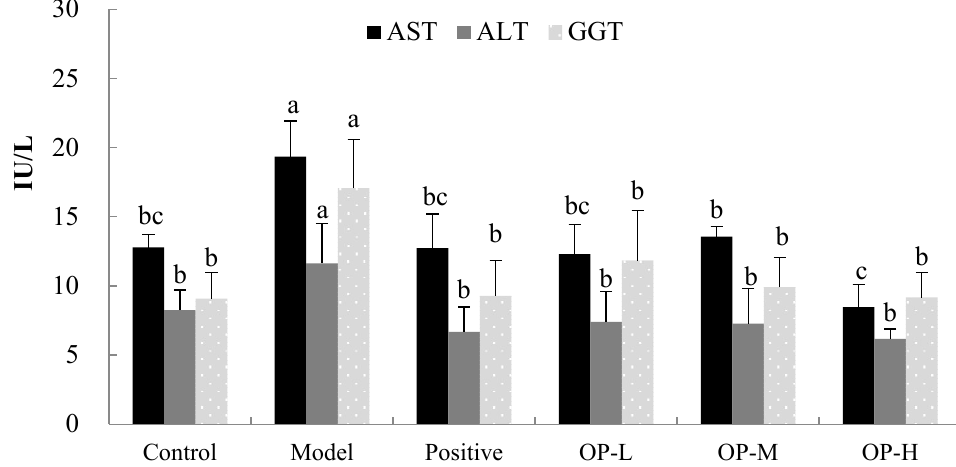
Figure 7. Effect of OP on the activities of AST, ALT, and GGT (means ± SD, n = 10). Bars with different superscripts (a, b, and c) were significantly different ( p < 0.01) according to ANOVA using the SPSS software and means were compared by Duncan’s multiple comparison post-test.